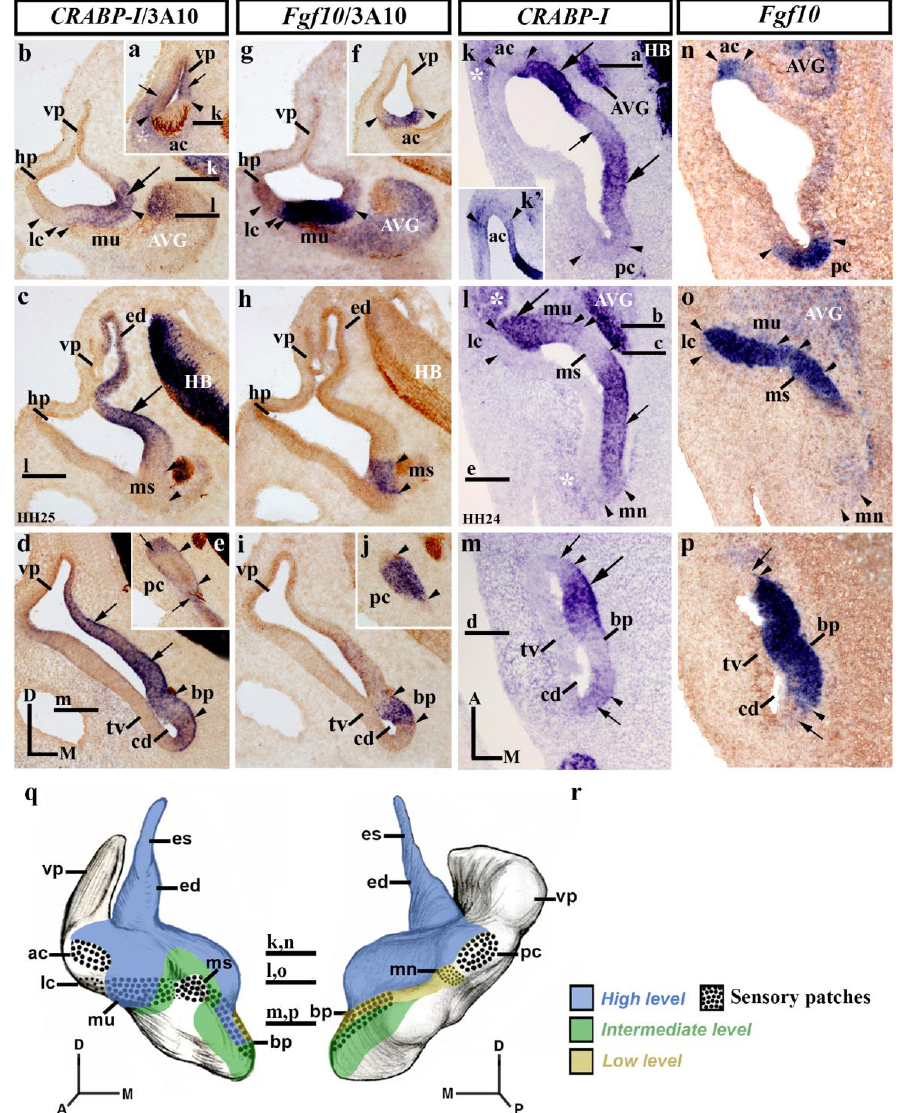
Figure 2. CRABP-I expression patterns at stage HH24/25. Transverse ( a – j ) and horizontal ( k – p ) sec- tions through the inner ear anlagen and treated with the CRABP-I probes. The sensory patches were detected by the Fgf10 probes ( f – j , n - p ). Otic innervation is identified by 3A10 immunoreaction in some sections ( a – j ). The presumptive areas of the developing sensory patches are indicated between arrowheads in all pictures. In a general view, CRABP-I expression was detected in the medial wall of stage HH24/25 otic anlagen (large and small arrows in ( b – d ), ( k – m )). The developing endolym- phatic duct was clearly included in the CRABP-I -labeling domain (ed in ( c )). CRABP-I expression labeled a very small portion of the vertical pouch (vp) in the anterior and posterior aspects of the otic anlagen (small arrows in ( a , e )), delimiting the anterior and posterior cristae, which were CRABP-I negative (ac and pc in ( a , e , k , k ′ )). The lateral crista and the macula sacculi were also devoid of CRABP-I expression (lc and ms; ( b , c , l )). The CRABP-I expressing domain included the macula utriculi (mu; ( b , l )). The macula neglecta showed very low CRABP-I expression (mn; ( l )). In the cochlear duct (cd), the CRABP-I expression was heterogeneous (arrows in ( d , m )) and also in the basilar papilla (bp; between arrow- heads in ( d , m )). The presumptive domain of the tegmentum vasculosum was devoid of CRABP-I expression (tv in ( d , m )). The acoustic-vestibular ganglion also showed CRABP-I expression (AVG in ( b , k , l )). Some aspects of the underlying mesenchyme displayed evident CRABP-I expression (asterisks in ( a , k , l )). ( q , r ), 3D CRABP-I expression pattern diagrams in anterior ( q ) and posterior ( r ) views of the stage HH24/25 inner ear. The horizontal sections are indicated. Dotted areas show the sensory patches. For the abbreviations, see the list. Orientation: A, anterior; D, dorsal; M, medial; P,